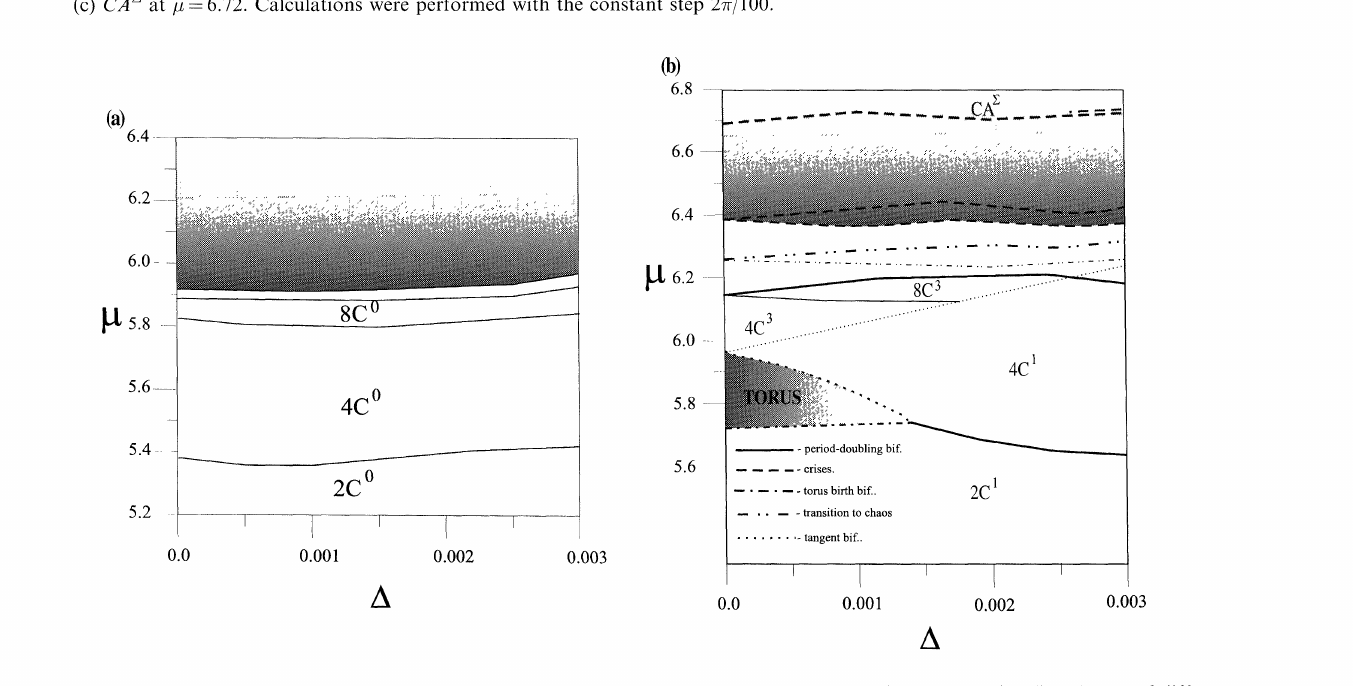
FIGURE 3 The distribution of phase difference for "out-of-phase" attractors: (a) 4CA) at #=6.038; (b) 2CA at #=6.36; (c) CA at #=6.72. Calculations were performed with the constant step 27r/100.